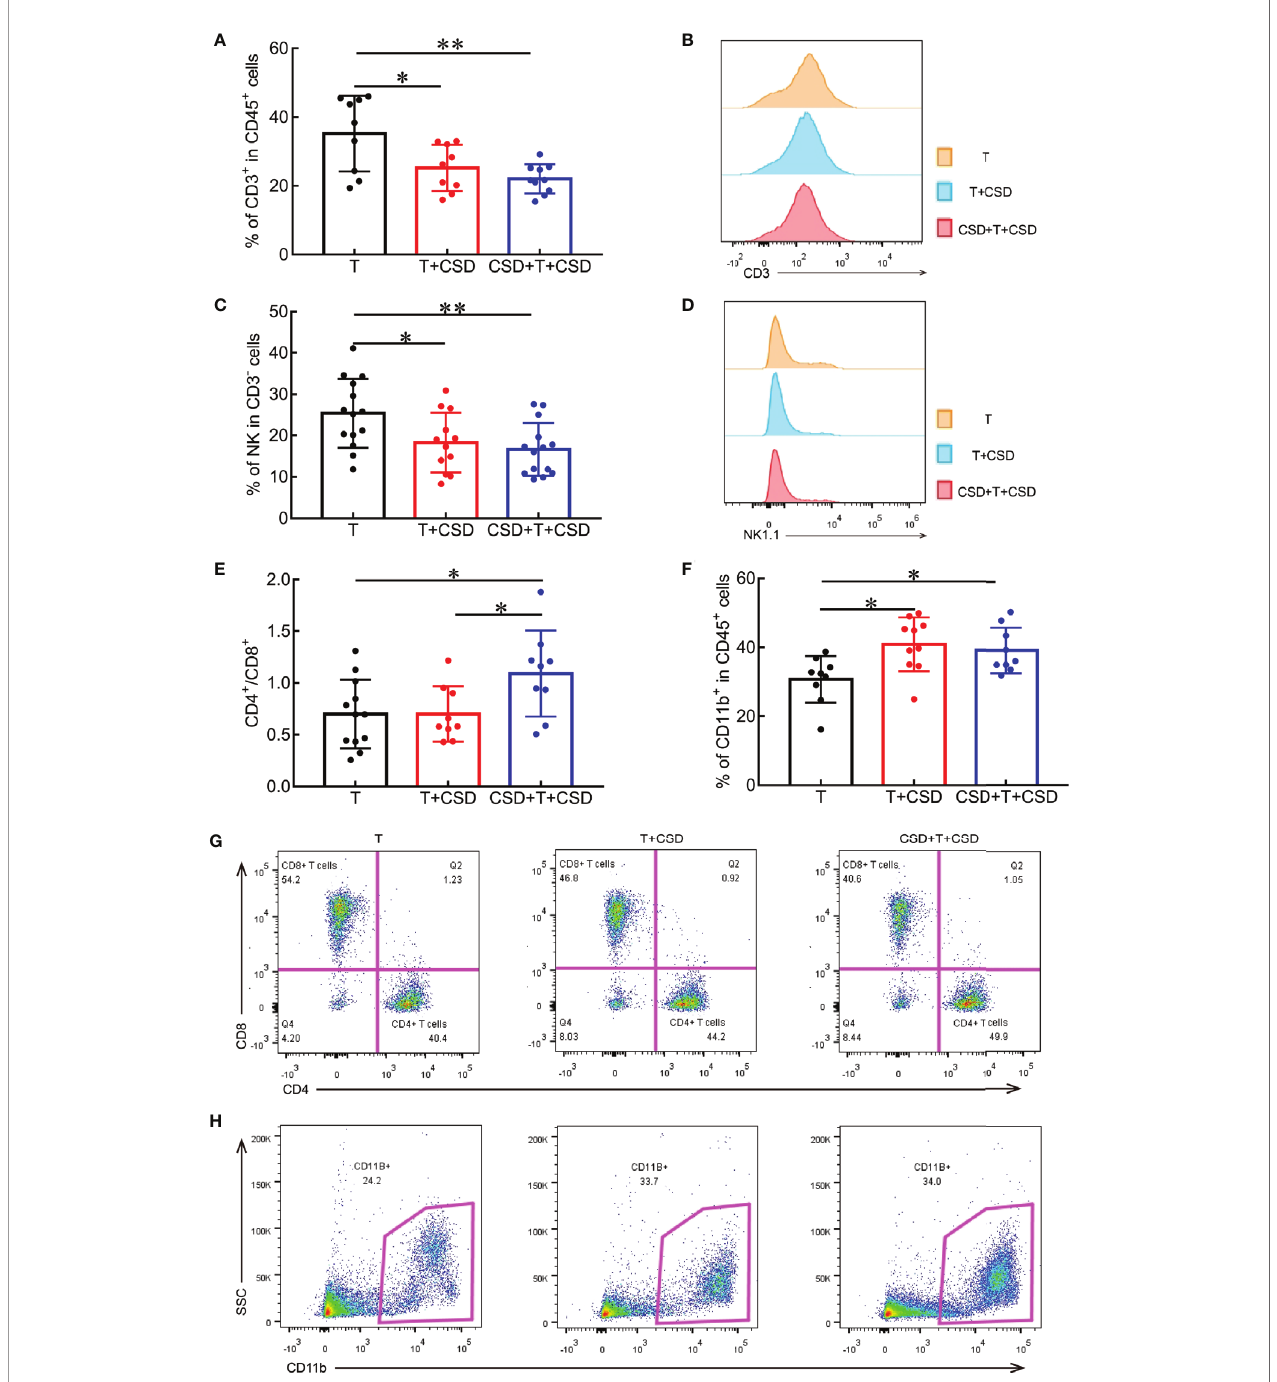
FIGURE 4 | CSD reduces the in fi ltration of antitumor immune cells and increases that of immunosuppressive cells into the tumor microenvironment. (A) Quanti fi cation of the proportions of intratumor CD3 + T cells among CD45 + cells in the T, T + CSD, and CSD + T + CSD groups. (B) Representative histogram of CD3 + T cells in tumor tissues of each group. (C) Quanti fi cation of mean fl uorescence intensity of NK cells in fi ltrating into tumor tissues. (D) Representative histogram of NK cells in the tumor microenvironment. (E, F) Quantitative analysis of fl ow cytometry results showing the CD4/CD8 ratio and percentages of CD11b + cells within tumor tissues in each group. (G, H) Representative scatterplots of CD4 + T cells and CD8 + T cells (G) and CD11b + cells (H) in fi ltrating into tumors in each group. Data represent mean ± SEM. * p < 0.05, ** p <